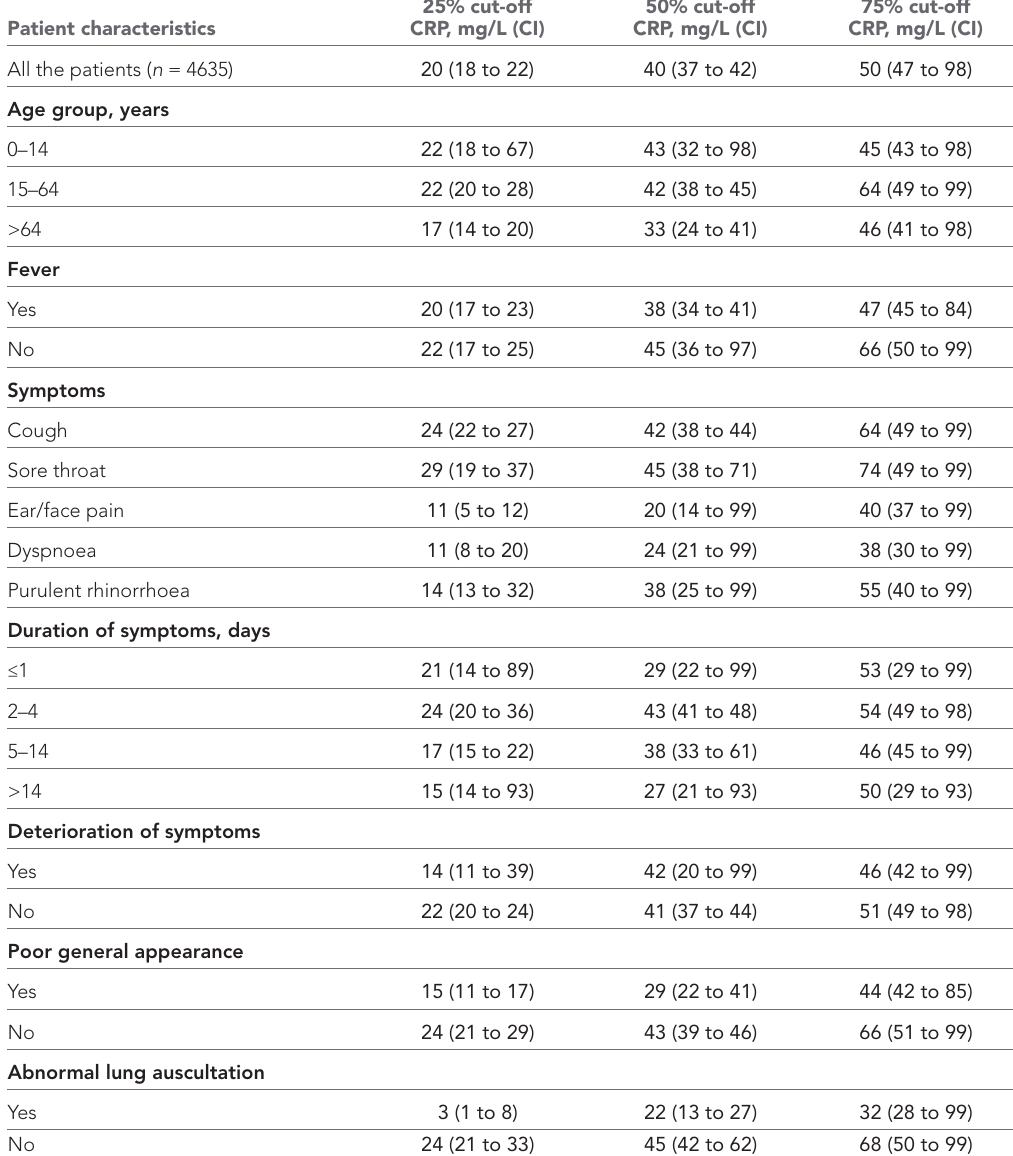
Table 3 C- reactive protein (CRP) cut- offs a used by 143 Danish GPs for patients with acute respiratory tract